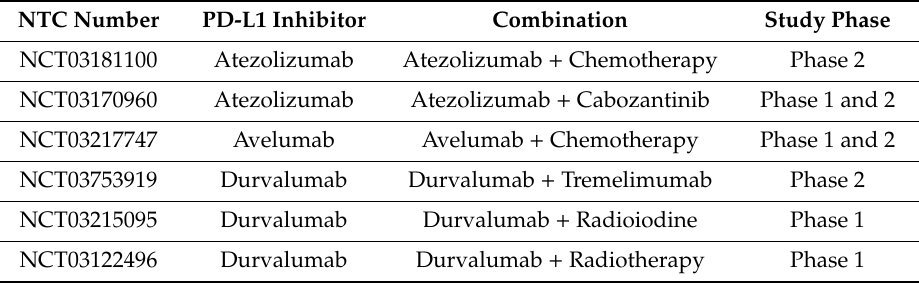
Table 2. Clinical Trials Evaluating the E ff ects of PD-L1 Inhibitors in Thyroid